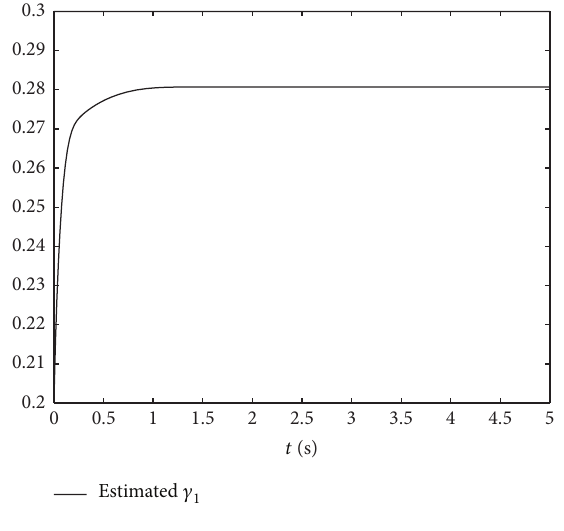
Figure 3: The estimation of unknown parameter 𝛾 1